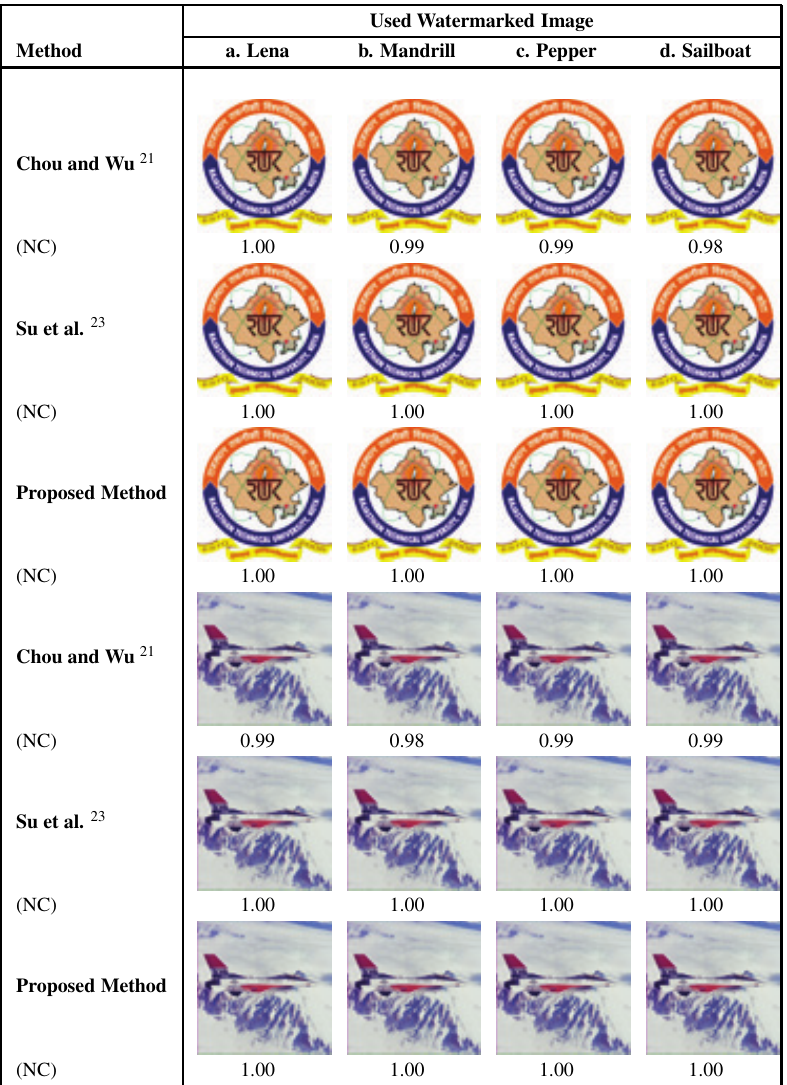
Figure 11: Comparison of extracted watermarks by considered and proposed methods along with their corresponding NC values. Columns shows extracted watermarks from watermarked image namely (a). Lena, (b). Mandrill, (c). Pepper, and (d). Sailboat using the considered and proposed methods mentioned in first column. First three rows shows the extraction of RTU logo while last three shows extraction of aeroplane watermark